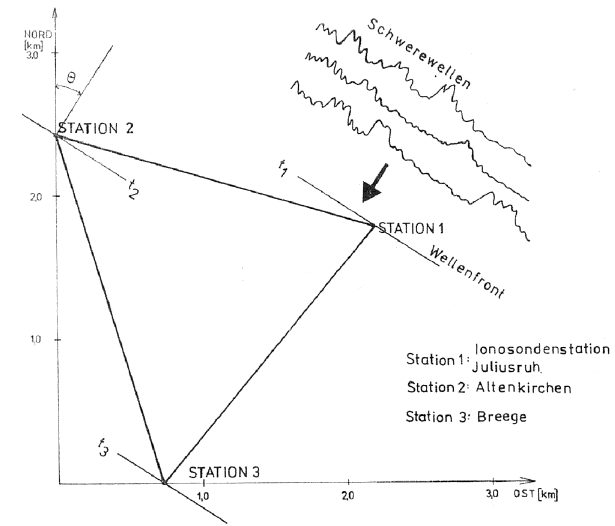
Figure 36. Geometry of the microbarograph network.